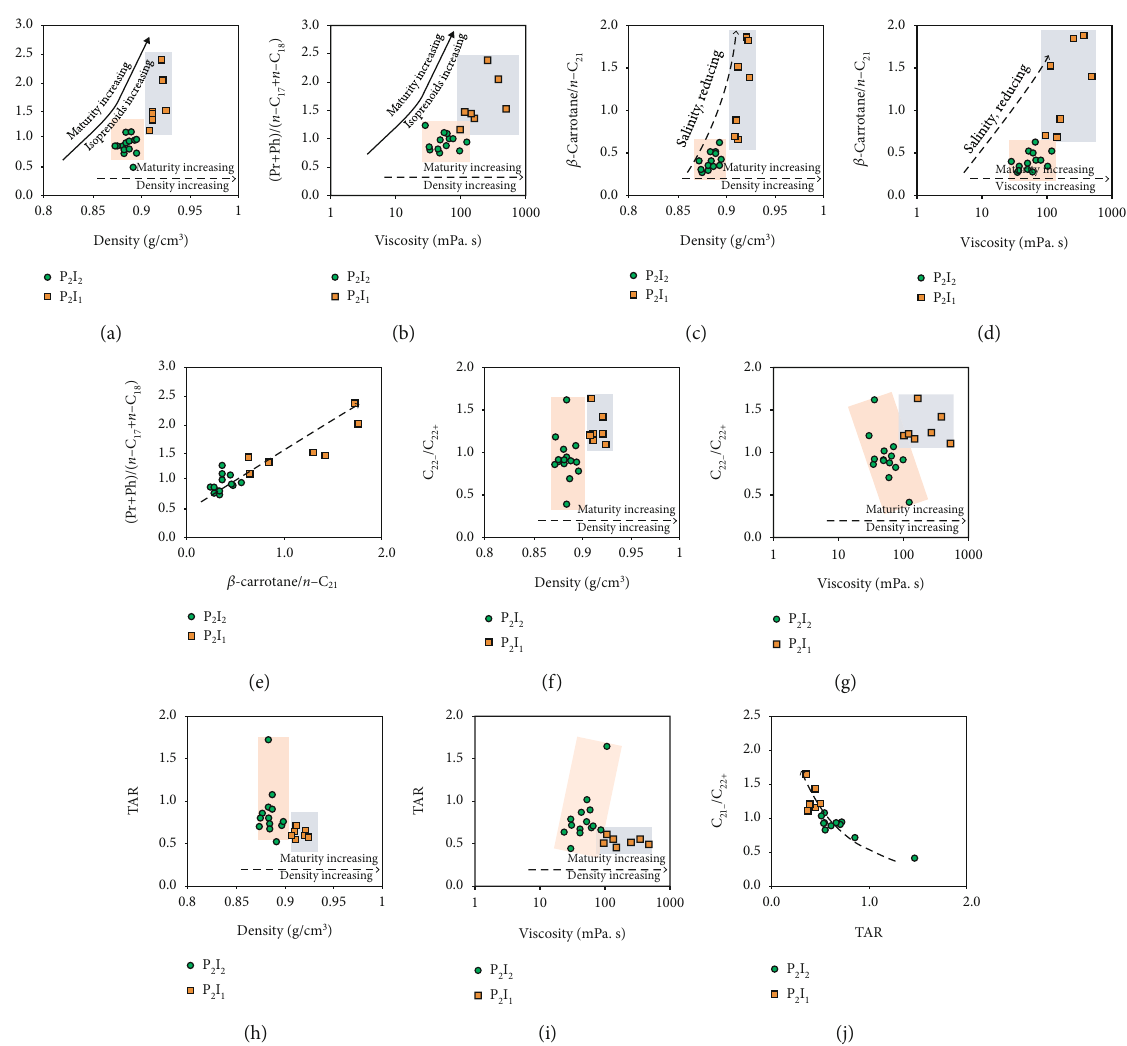
Þ ratio; (c) density and (d) viscosity versus β - + n − C 17 18 Þ ratio; (f) density and (g) viscosity versus C + n − C 17 18 -/C + ratio, for the crude oil sample in the Lucaogou 21 22